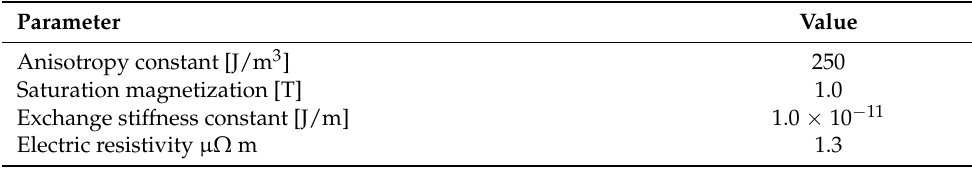
Table 1. Magnetic characteristics and electric resistivity.